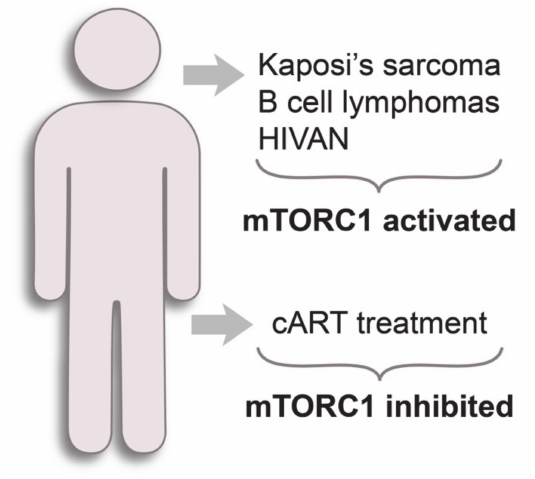
Figure 3. mTORC1 status in HIV-1-related